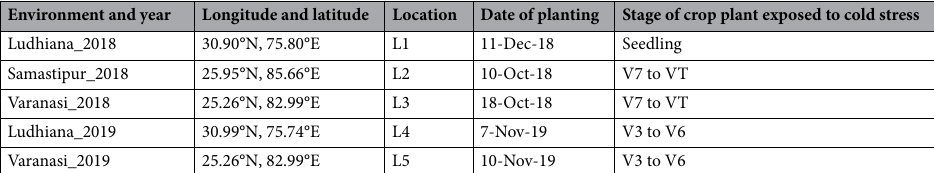
Table 1. Location and date of planting and crop stage exposed to low